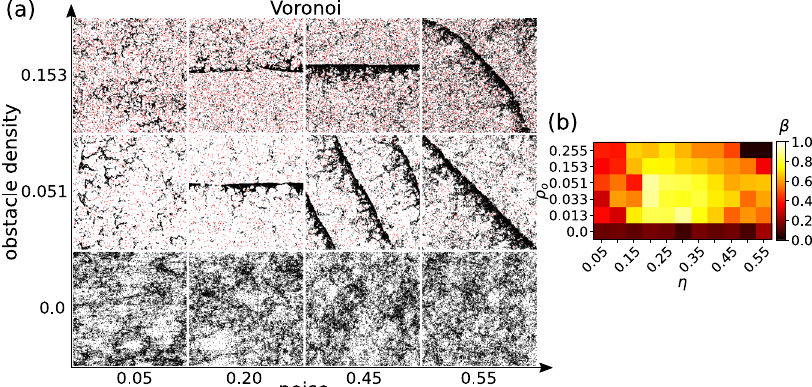
Fig. 6 Bands in Voronoi interaction. a Typical macroscopic con fi gurations observed in a system with Voronoi interaction, for different obstacle densities ρ o , and noise intensities η . Black dots are particles and red dots are obstacles. In obstacle-free environments ( ρ o = 0), we observe rather homogeneous structures with no density segregation in the form of cluster or band. In heterogeneous environments, we observe cluster-like structures at low noise values, here η = 0.05, these clusters connect together to form bands at noise around η = 0.20 and lead to a maximum in polar order parameter (see Fig. 3c). Bands continue to form at higher noise values. b Density modulation parameter β in different regions of phase space speci fi ed with obstacle density ρ o and noise intensity η corresponding to the system in panel ( a ). It should be noted that since macroscopic structures for Voronoi interaction are different from those with k -nearest neighbors interaction ( k NN, where k is the number of neighboring objects), with clusters at low noise values and bands at higher noise values, the same color (i.e., reddish regions) may refer to different types of structures when comparing to k NN interaction, and even for Voronoi when comparing high and low noise